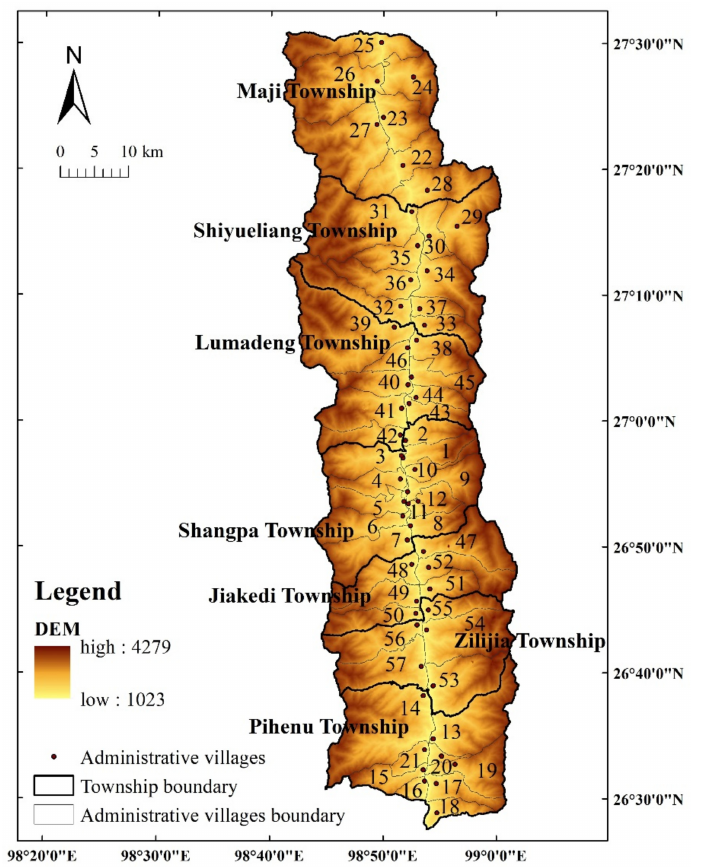
Figure 1. An overview of the study area; Note: Administrative Village No.: 1. Lazhudi Village